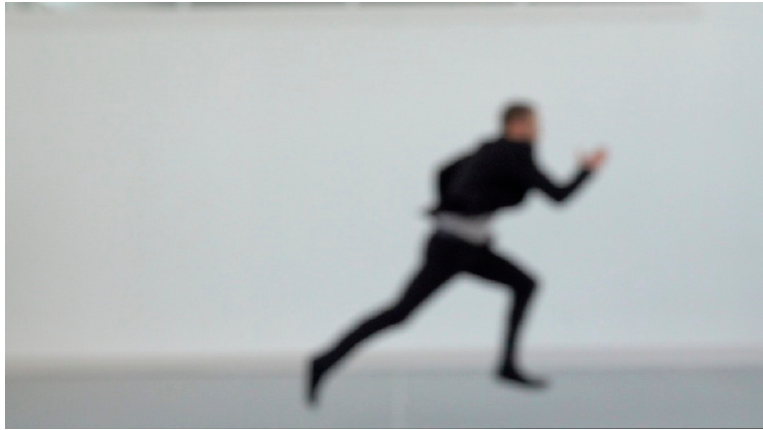
Figure 5. Dalziel + Scullion, still from “Sàl”, 2018. Image courtesy of Dalziel + Scullion.